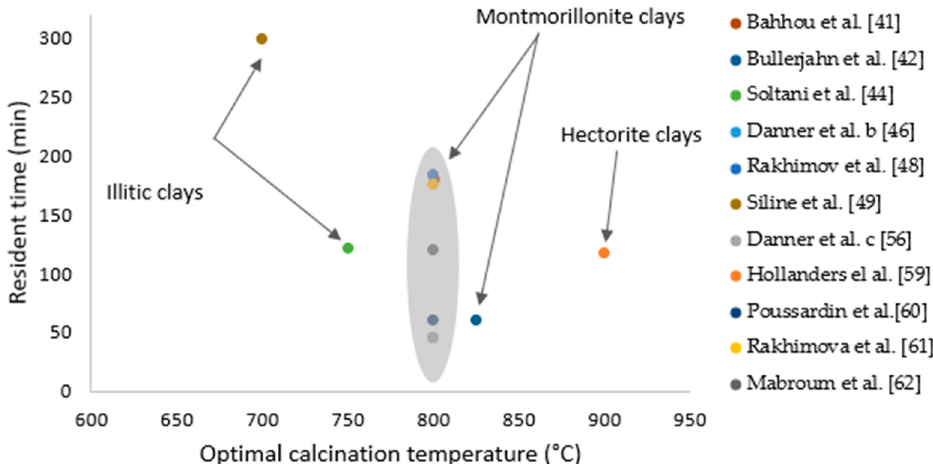
Figure 3. The resident time as a function of the optimal activation temperature for the studied marl used as SCMs. Bahhou et al. [41], Bullerjhan et al. [42], Soltani et al. [44], Danner et al. b [46], Rakhimov et al. [48], Siline et al. [49], Danner et al. c [56], Hollanders et al. [59], Poussardin et al. [60], Rakhimova et al. [61], Mabroum et al. [62]